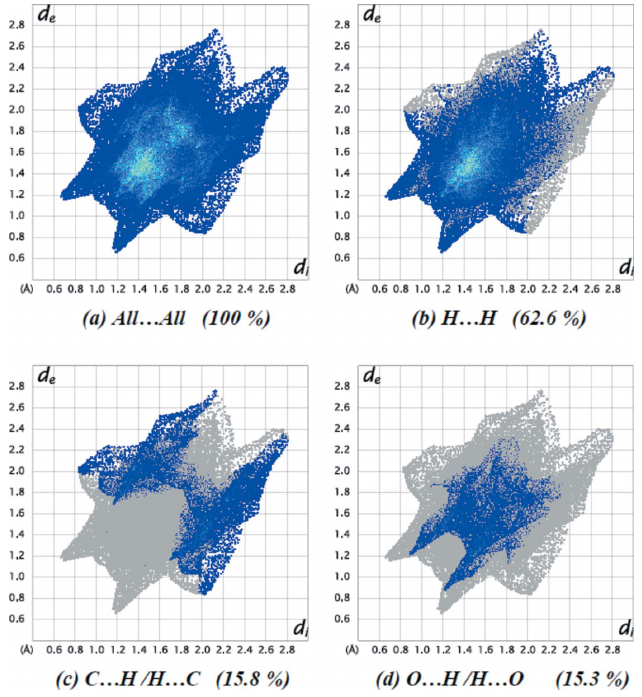
Figure 4 Two-dimensional fingerprint plots for the title compound, showing ( a ) all interactions, and delineated into ( b ) H (cid:3)(cid:3)(cid:3) H, ( c ) C (cid:3)(cid:3)(cid:3) H/H (cid:3)(cid:3)(cid:3) C and ( d ) O (cid:3)(cid:3)(cid:3) H/H (cid:3)(cid:3)(cid:3) O interactions. The d i and d e values are the closest internal and external distances (in A˚ ) from given points on the Hirshfeld